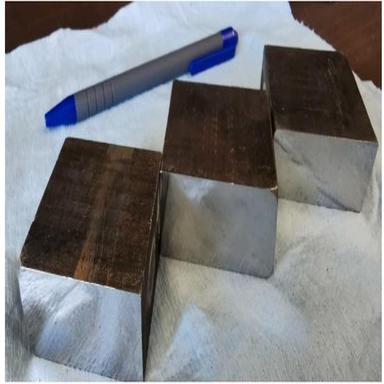
HTHA samples used for the experiment with three levels of HTHA degradation.